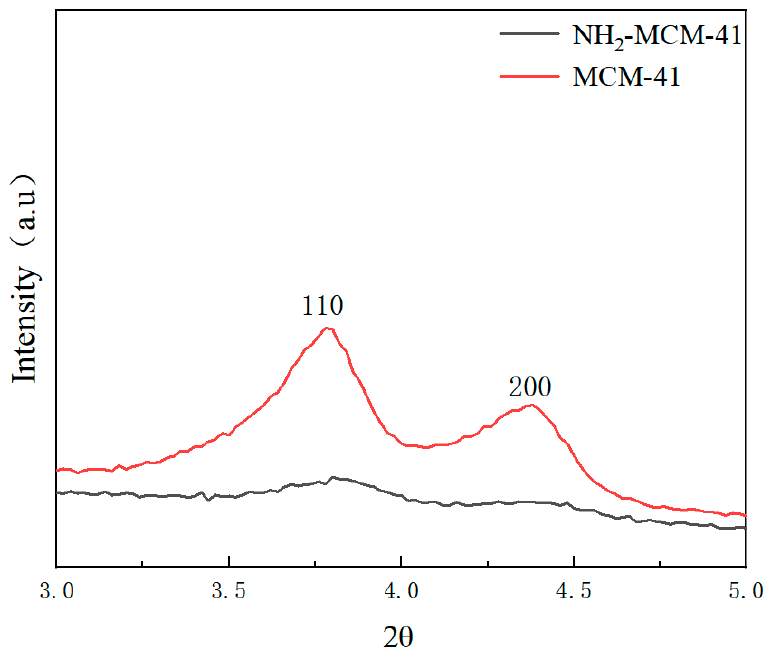
Figure 5. XRD patterns of MCM-41 (red) and NH 2 -MCM-41